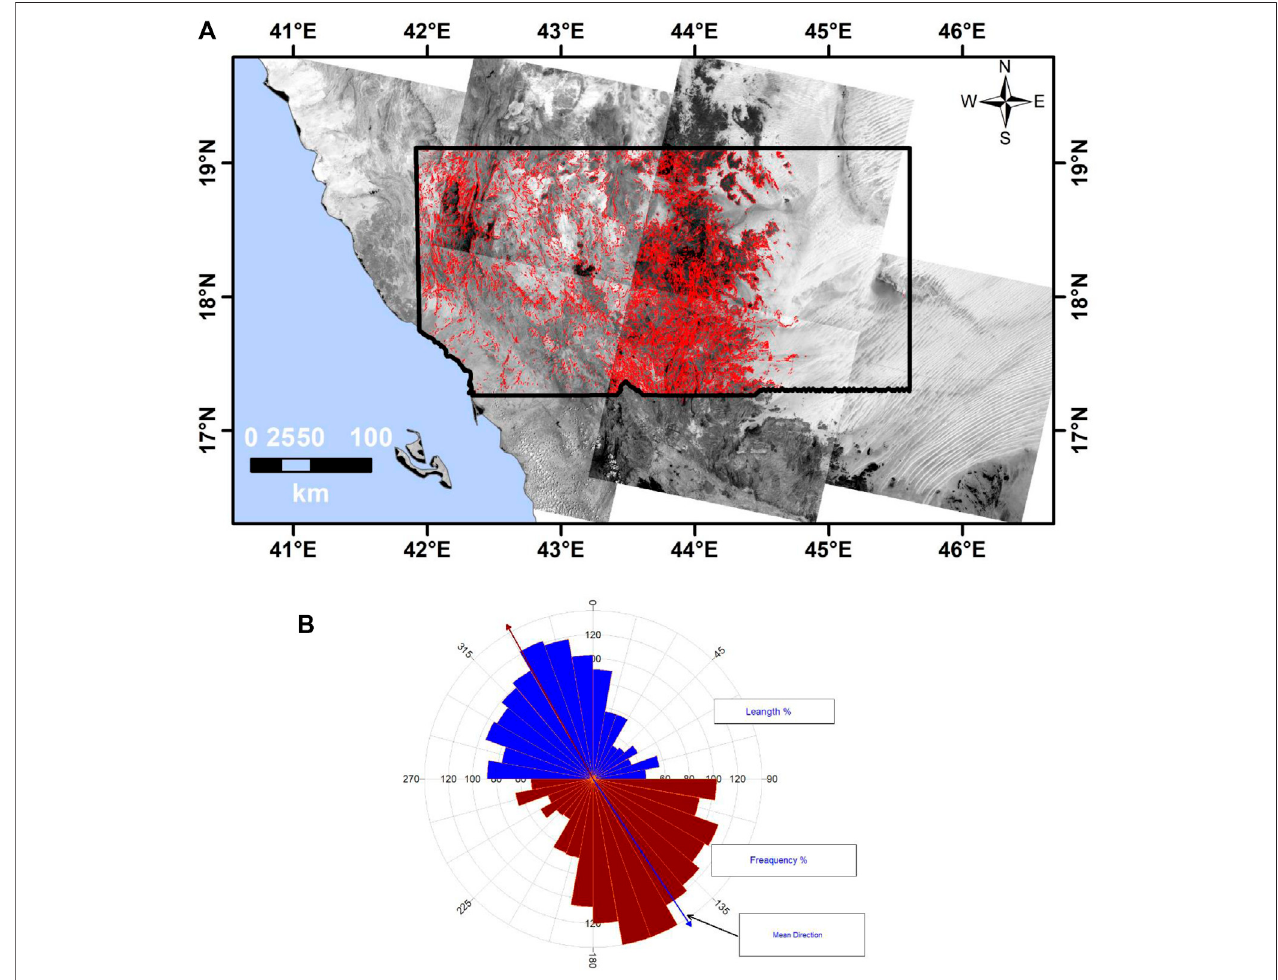
FIGURE 9 | (A) Landsat images with extracted surface lineaments, and (B) a rose diagram with the major structural patterns.